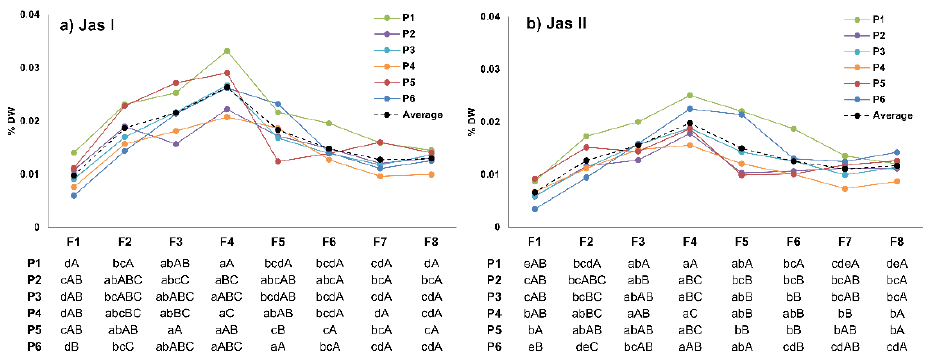
Figure 6. Content of ( a ) jasmolin I and ( b ) jasmolin II across the eight flower developmental stages in six Dalmatian pyrethrum populations. Lower case letters refer to differences between phases in the same population, while uppercase letters refer to differences between populations within the same phase.